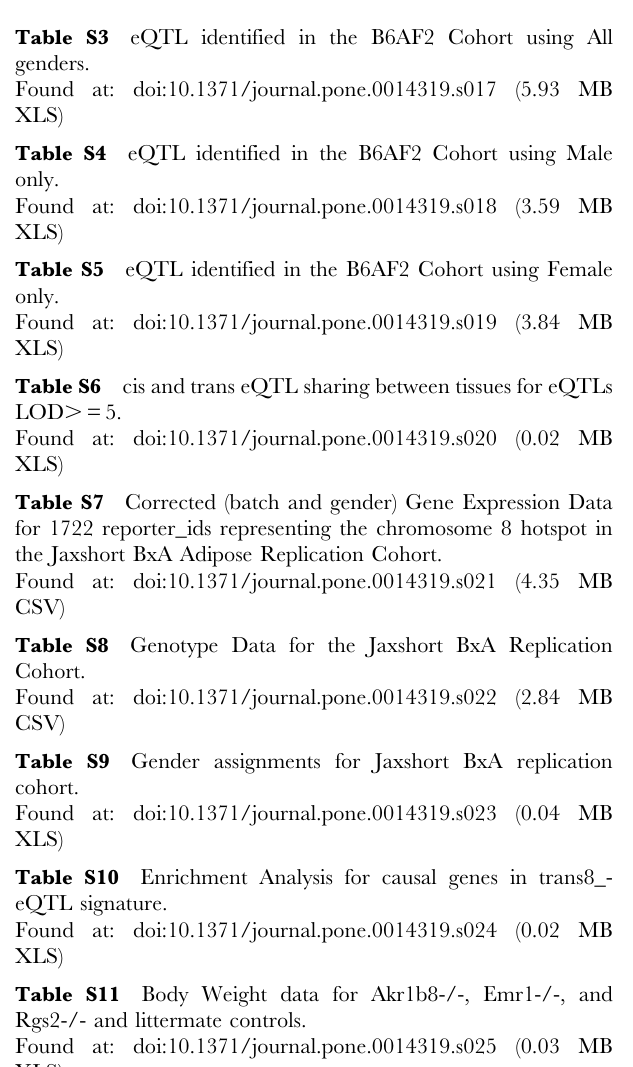
Table S3 eQTL identified in the B6AF2 Cohort using All genders.